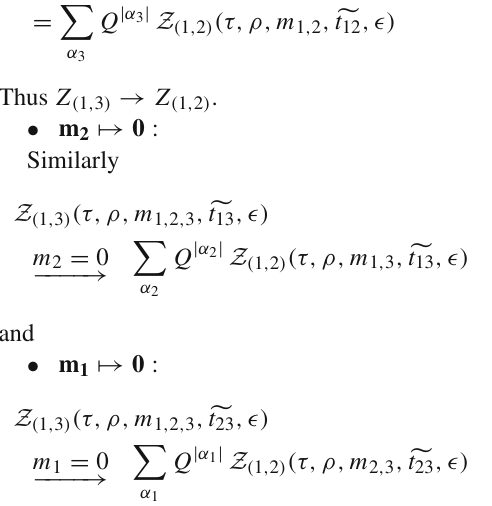
( a ) (b) (c) Fig. 9 Three possible degenerations of the partition function Z 1 , 3 (cid:4) = Q | α 3 | Z ( 1 , 2 ) (τ, ρ, m 1 , 2 , (cid:25) t 12 , α 3